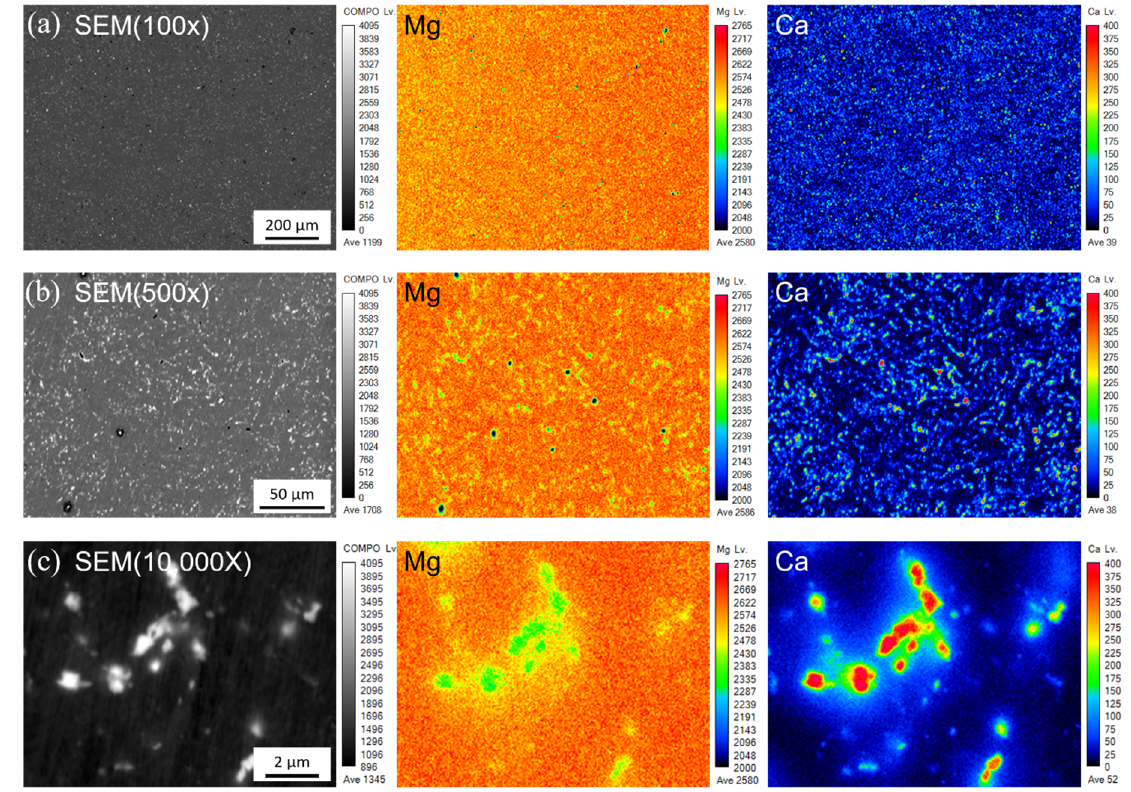
Figure 2. SEM surface observation and EPMA element distribution of as-extruded Mg–Ca alloy at a magnification of ( a ) 100×, ( b ) 500×, and ( c )10,000×. The SEM images were the backscattered electron images (BSE).